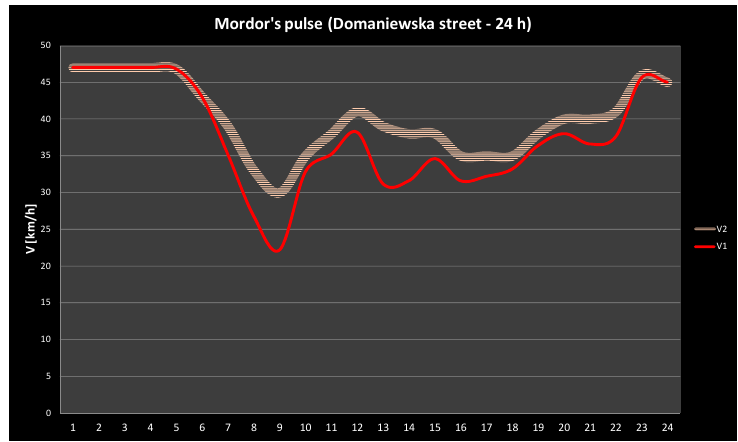
Figure 15. A daily change in speed for Domaniewska Street—reference data and the auction with “patient agents” variation.